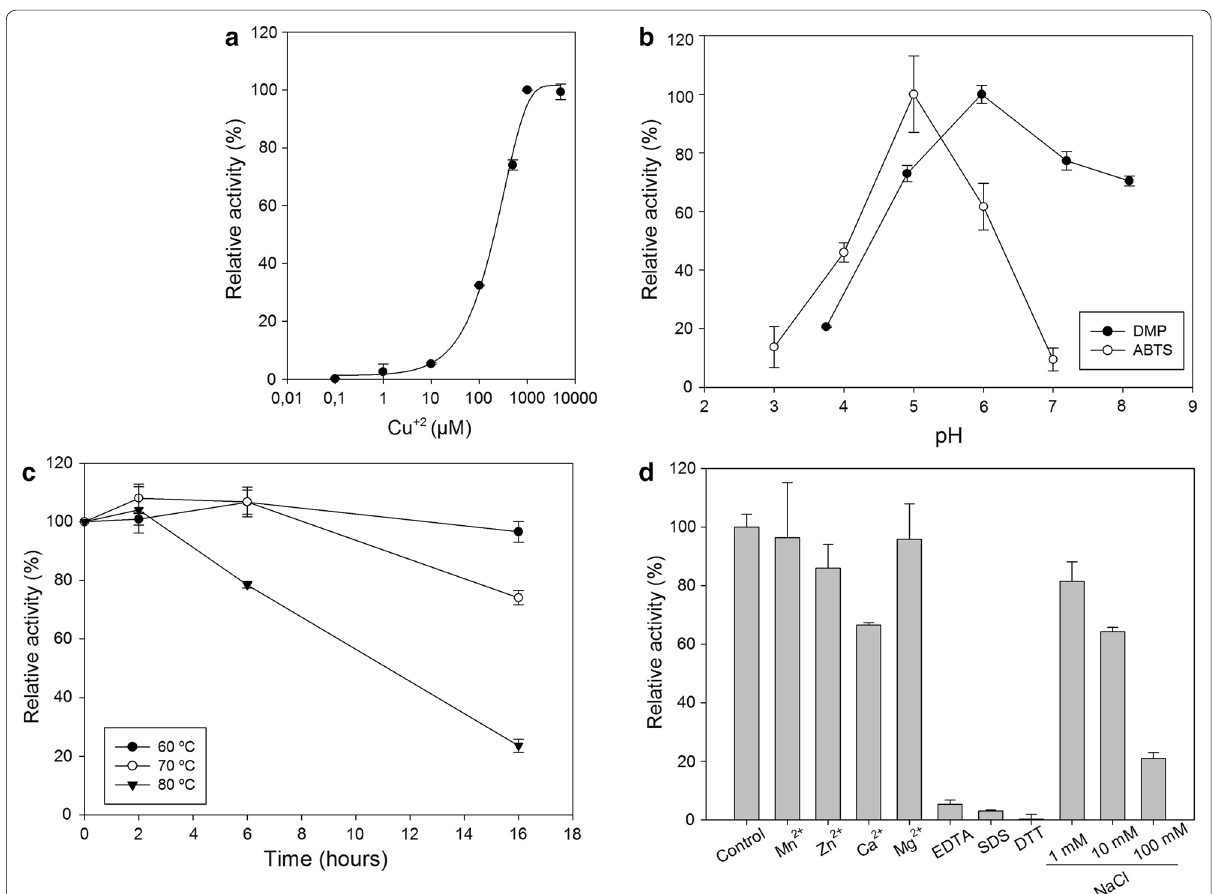
Fig. 2 Dependence of LAC_2.9 activity on reaction conditions. a Copper dependence of activity; b pH dependence of activity; c thermal stability profile obtained measuring the residual activity on ABTS at 60 °C, after incubating the enzyme at 60, 70 and 80 °C up to 16 h; d effect of metal ions,